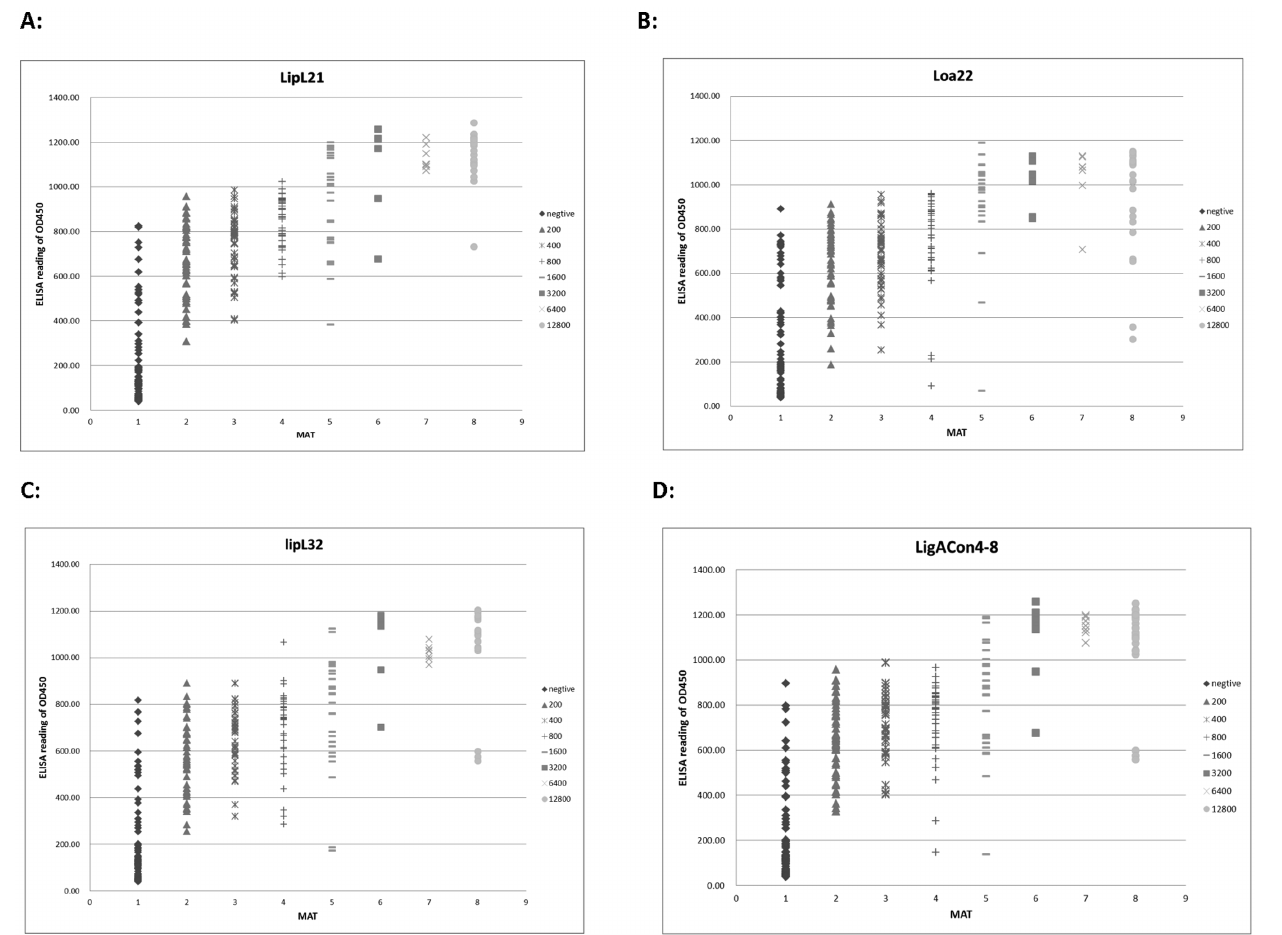
Fig. 1. Graph of the ELISA samples showing the IgG ELISA reactivity of 305 canine sera. The x axis indicates the MAT titers of the tested sera. The y axis indicates the ELISA reading at OD450. A. LipL21; B. Loa22; C, LipL32; D, LigACon4-8.